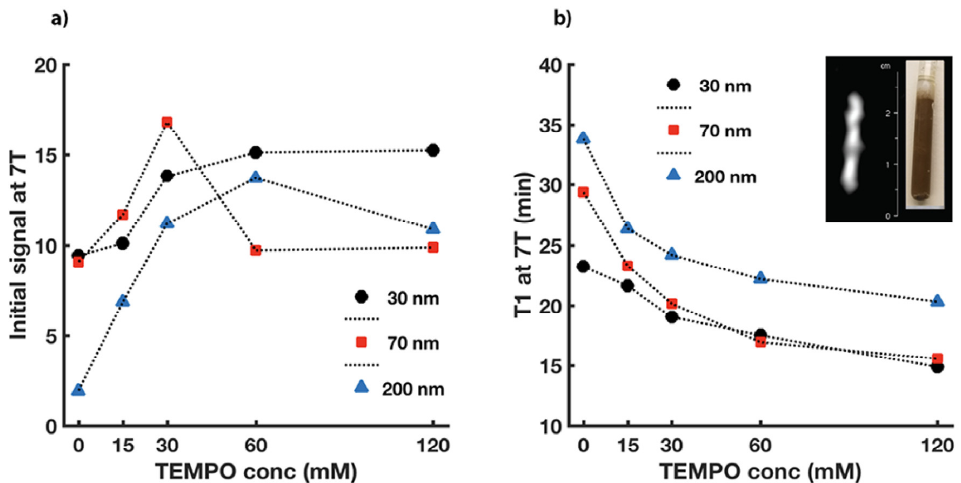
Figure 20. Optimization of TEMPO concentrations. ( a ) Calibration of TEMPO concentration vs 29 Si hyperpolarization level for Si NPs of different size: 30, 70 and 200 nm. Data collected (following DNP) at room temperature and 7 T. ( b ) Effect of TEMPO concentration on 29 Si T 1 decay for NPs indicated in ( a ), measured at room temperature and under 7 T. Inset: 29 Si MRI of the Si NP sample (70 nm/30 mM TEMPO) within its sample tube following the corresponding decay study in ( b ); the MRI was taken 65 min after DNP and after exciting the phantom with a 10° pulse every 5 min to acquire the 29 Si spectra used for the T 1 calculation. Photograph to right of 29 Si MRI shows sample. (Reprinted with permission from Reference [56]. © (2018) American Chemical Society).